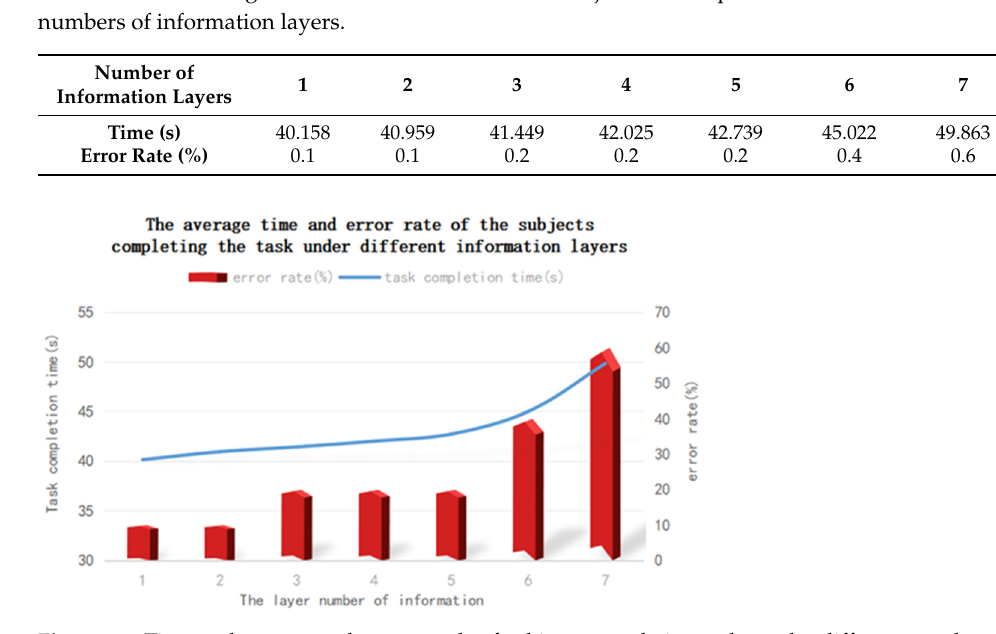
Figure 15. Time and error rate change trends of subjects completing tasks under different numbers of information layers. Table 11. The average time and error rates of the subjects to complete the task under different num- bers of information layers. Table 12. The average eye movement data of subjects completing tasks under different information layers.